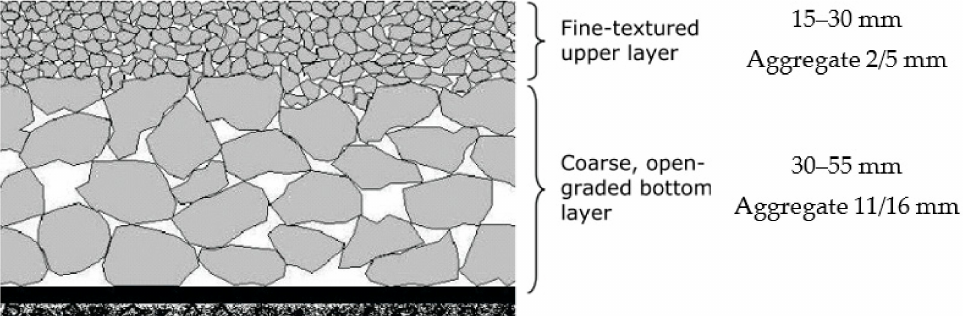
Figure 10. Twin layer scheme (adapted from